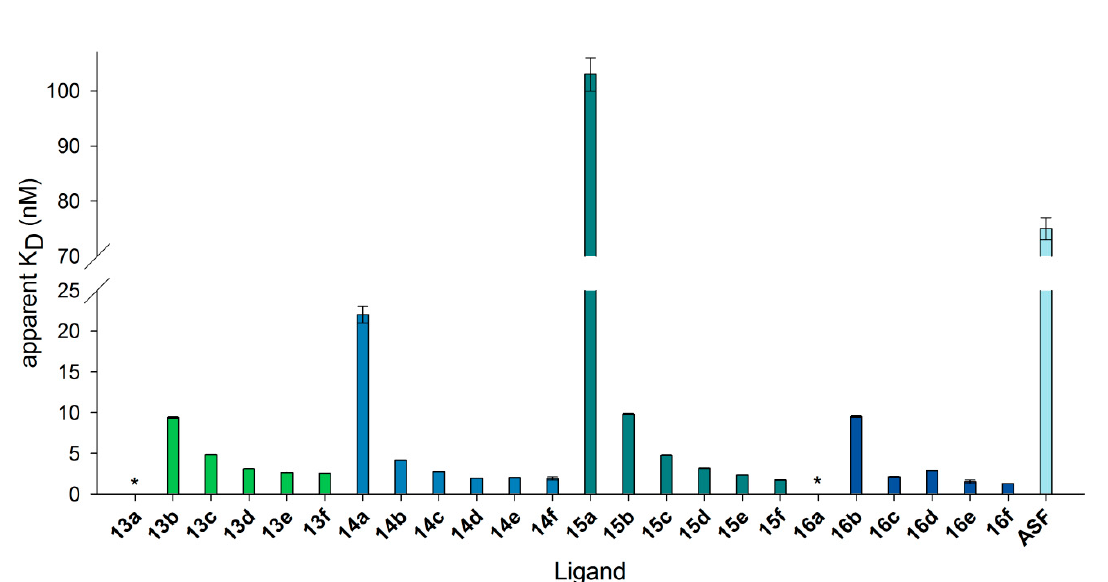
Figure 8. K D values resulting from binding of neo-glycoproteins on immobilized Gal-3 in SPR measurements. Gal-3 was immobilized on a sensor chip, and binding to neo-glycoproteins as well as ASF was monitored in flow (20 µL/min). Apparent K D values were calculated for one concentration